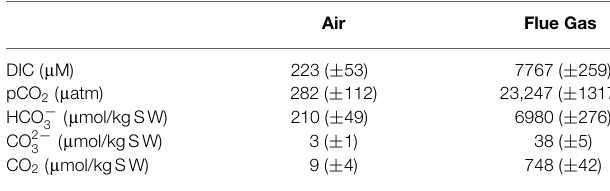
TABLE 1 | Carbon chemistry of Heterosigma akashiwo cultures bubbled with air (control) or a simulated flue gas containing 12% CO 2 and 150ppm NO .